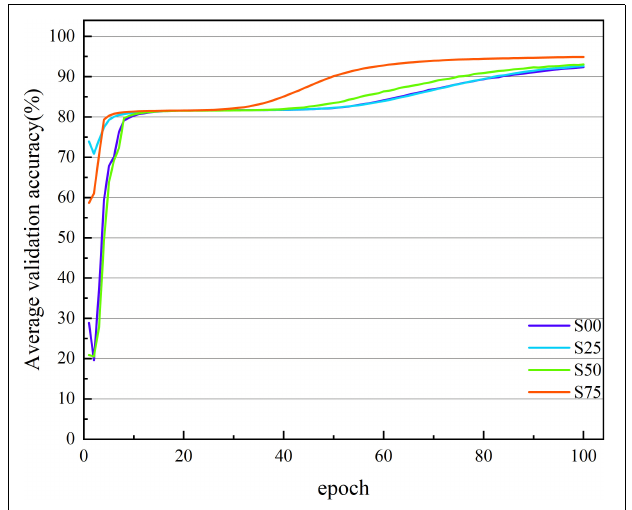
four segmentation strategies. The ROC curve obtained from the data set S75 is closer to the upper left corner than the other three